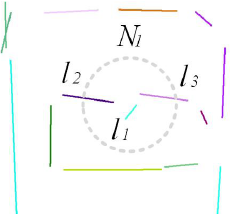
Figure 4. Neighboring set N 1 = { l 1 , l 2 , l 3 } of a line segment l 1